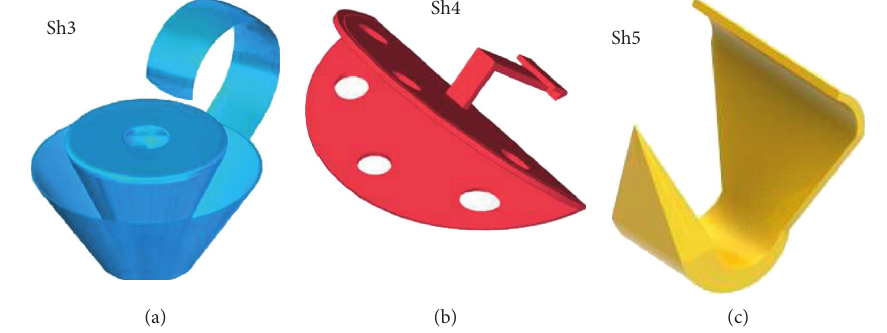
Figure 3: Shapes used in the tests of the DPE early validation. Table 6: Results of the tests in the early DPE